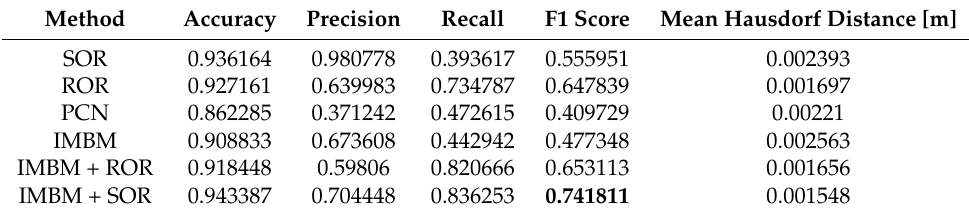
Table 5. The medians of each evaluated metric in whole